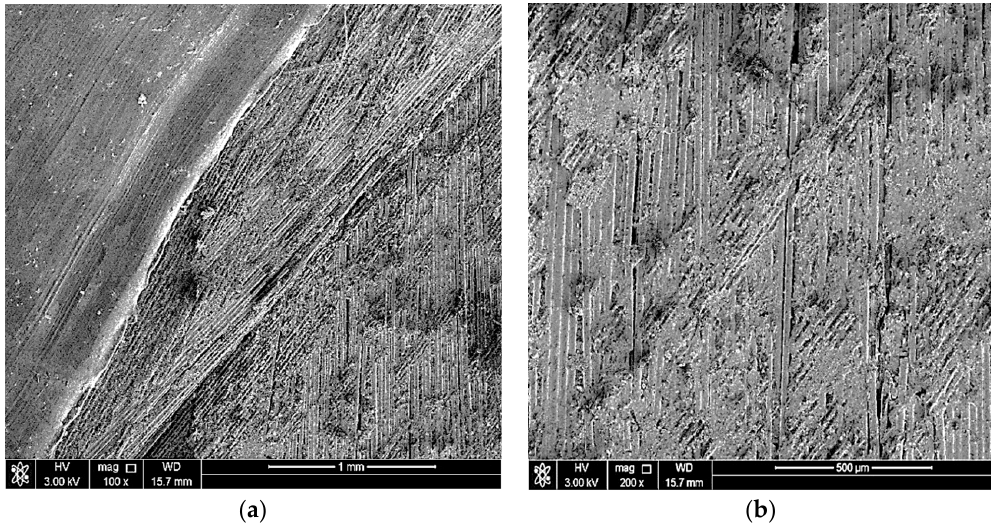
Figure 4. SEM images of the fractured region at ( a ) 100× and ( b ) 200×